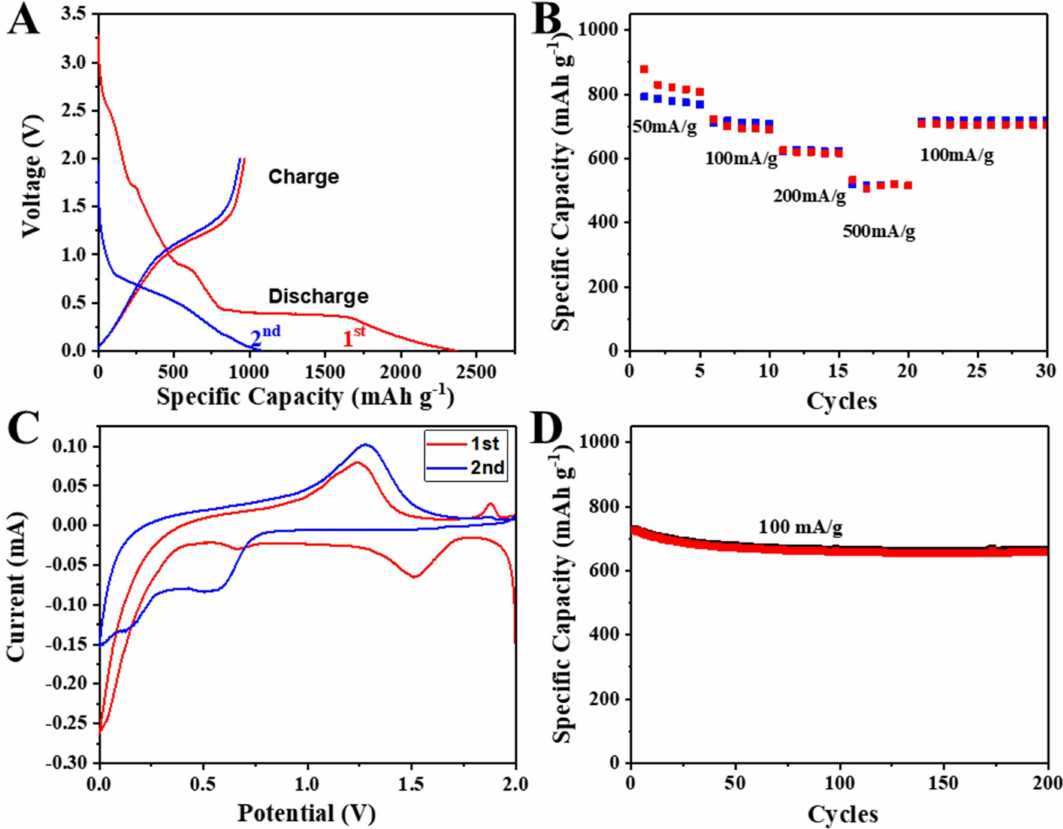
Figure 4. Electrochemical data of α -MnO 2 anode electrode. ( A ) charge-discharge profiles for first two cycles, ( B ) rate study, ( C ) cyclic voltammetry curve, and ( D ) constant current (100 mA g − 1 )